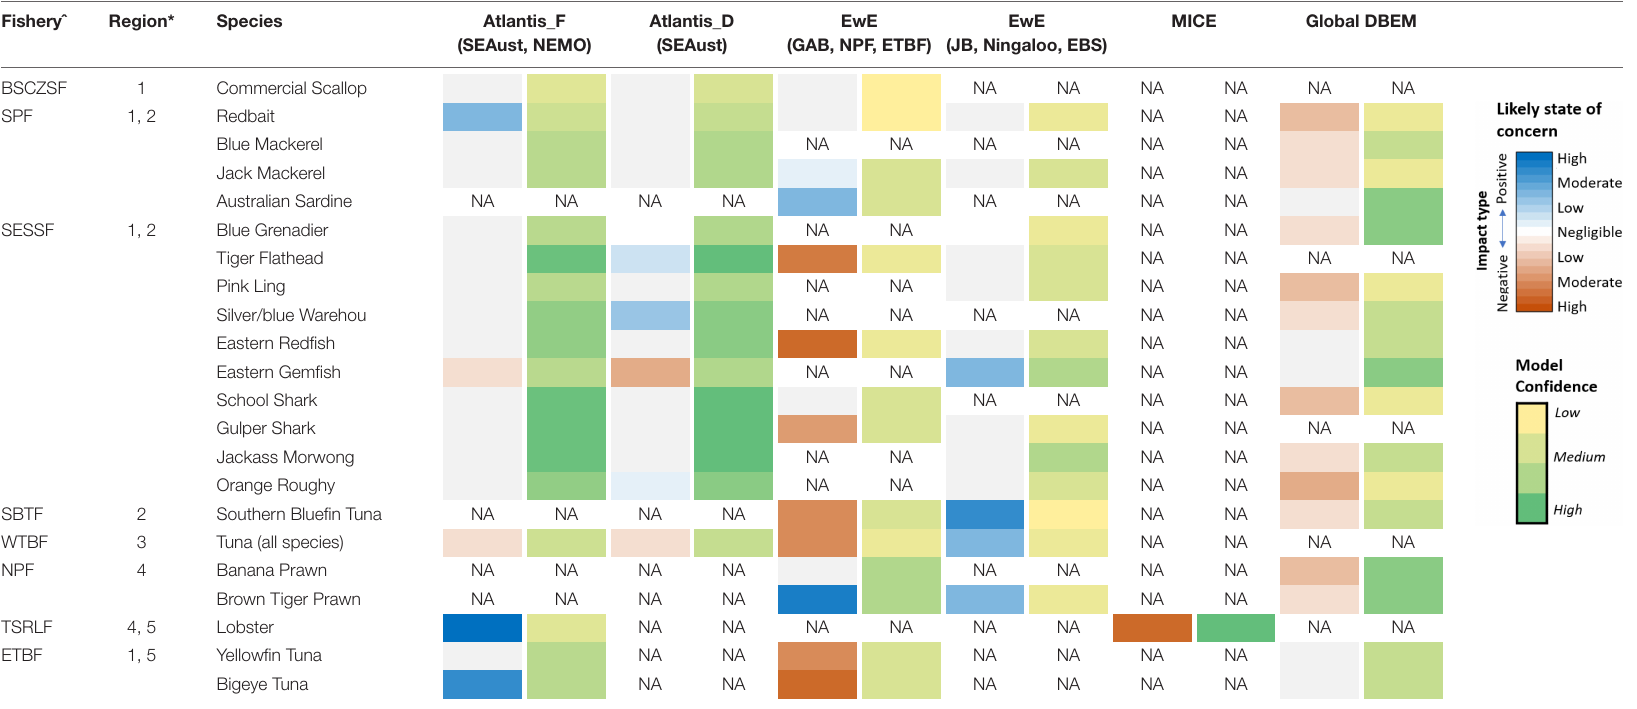
ce TABLE 4 | Inter-model comparisons of the projected likely states of concern to climate change in key commercial species at the end of 2050 and the associated level of confidence. Fisheryˆ Region*